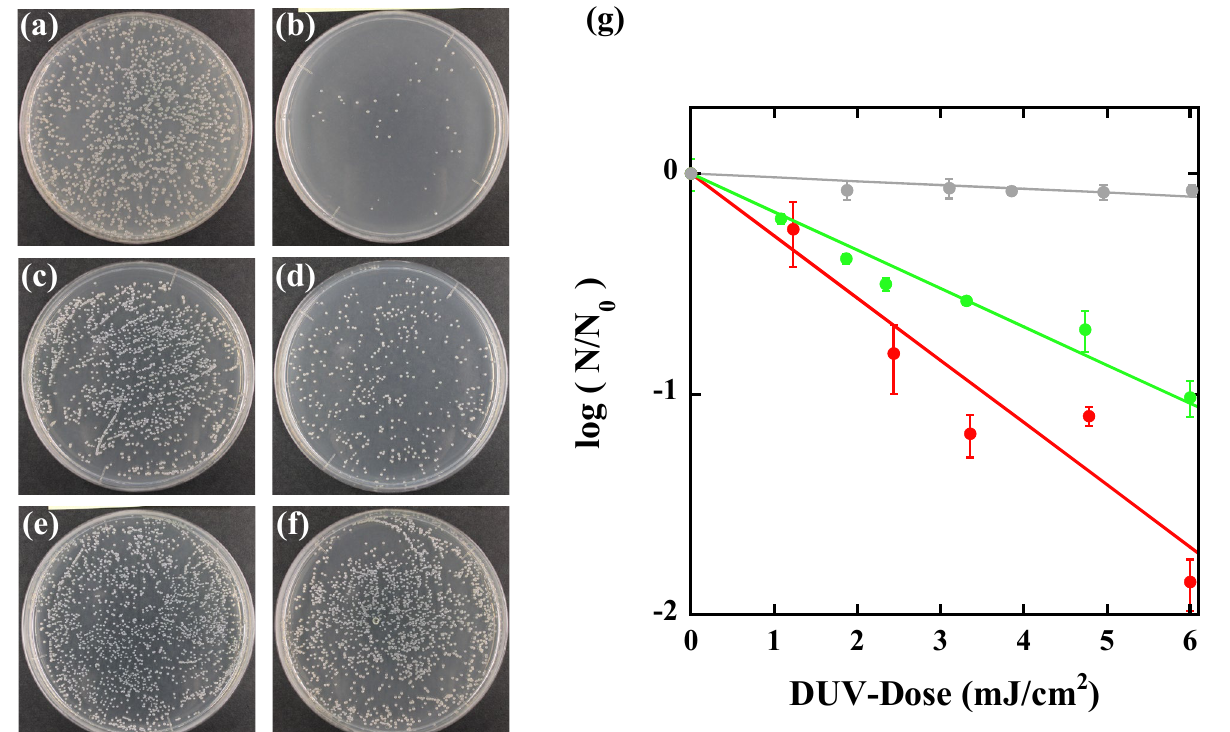
Figure 5. Efficacy of inactivation by using the WW purification system for P. aeruginosa . ( a , c , e ) are the results of control plate (0 mJ/cm 2 DUV dose), ( b ) is the plate inactivated by a 6.0 mJ/cm 2 dose of 265 nm irradiation, ( d ) is the plate inactivated by a 6.0 mJ/cm 2 dose of 280 nm irradiation, and ( f ) is the plate inactivated by a 6.0 mJ/cm 2 dose of 308 nm irradiation. ( g ) Reduction rate of inactivation as a function of the magnitude of the dose for each wavelength. The red circles are obtained by 265 nm irradiation, the green circles are obtained by 280 nm irradiation, and the gray circles are obtained by 308 nm irradiation. The reduction curves of inactivation for each irradiation wavelength are fitted by κ κ κ 265 = 0.65, 280 = 0.40, and 308 = 0.04. These values agree well with the values described in Table 1, which are obtained by the wavelength-dependent inactivation rate constant